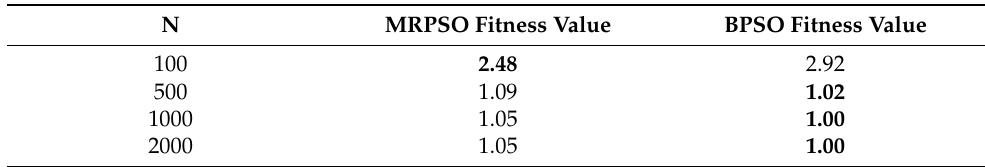
Table 7. Mean of the particle best-fit values in MRPSO and BPSO on f 2 . The bold numbers refers to the better results.